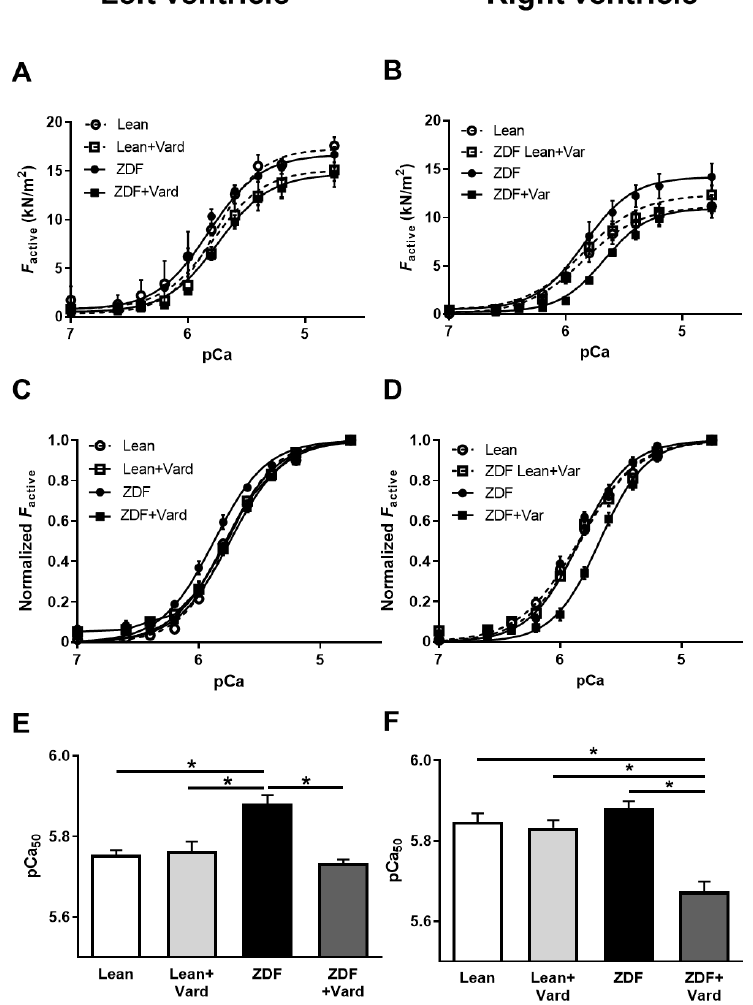
Figure 3. Ca 2+ -sensitivity of isometric force production (pCa 50 ) in isolated, permeabilized left ventricular ( A , C , E ) and right ventricular ( B , D , F ) cardiomyocytes of rat hearts. Means of active force values (F active ) are given at different Ca 2+ concentrations for the left ( A ) and right ( B ) ventricles from the Lean, Lean + Vard, ZDF, and ZDF + Vard groups. Average sarcomere length was set to 2.3 µm. F active values at submaximal Ca 2+ concentrations (pCa 5.4 – 7.0) were normalized to F max (pCa 4.75) to illustrate differences in pCa 50 values ( C , D ). Bar graphs ( E , F ) show the results of statistical analyses on pCa 50 values of the four experimental groups. F max (pCa 4.75): LV Lean, 17.59 ± 0.85 kN/m 2 ; LV Lean + Vard, 15.11 ± 1.75 kN/m 2 ; LV ZDF, 16.67 ± 0.79 kN/m 2 ; LV ZDF + Vard, 14.68 ± 0.69 kN/m 2 ; RV Lean, 11.15 ± 1.17 kN/m 2 ; RV Lean + Vard, 12.36 ± 0.97 kN/m 2 ; RV ZDF, 14.20 ± 1.39 kN/m 2 ; RV ZDF + Vard, 10.96 ± 0.49 kN/m 2 . pCa LV Lean, 5.76 ± 0.02; LV Lean + Vard, 5.77 ± 0.02; LV ZDF, 50 :